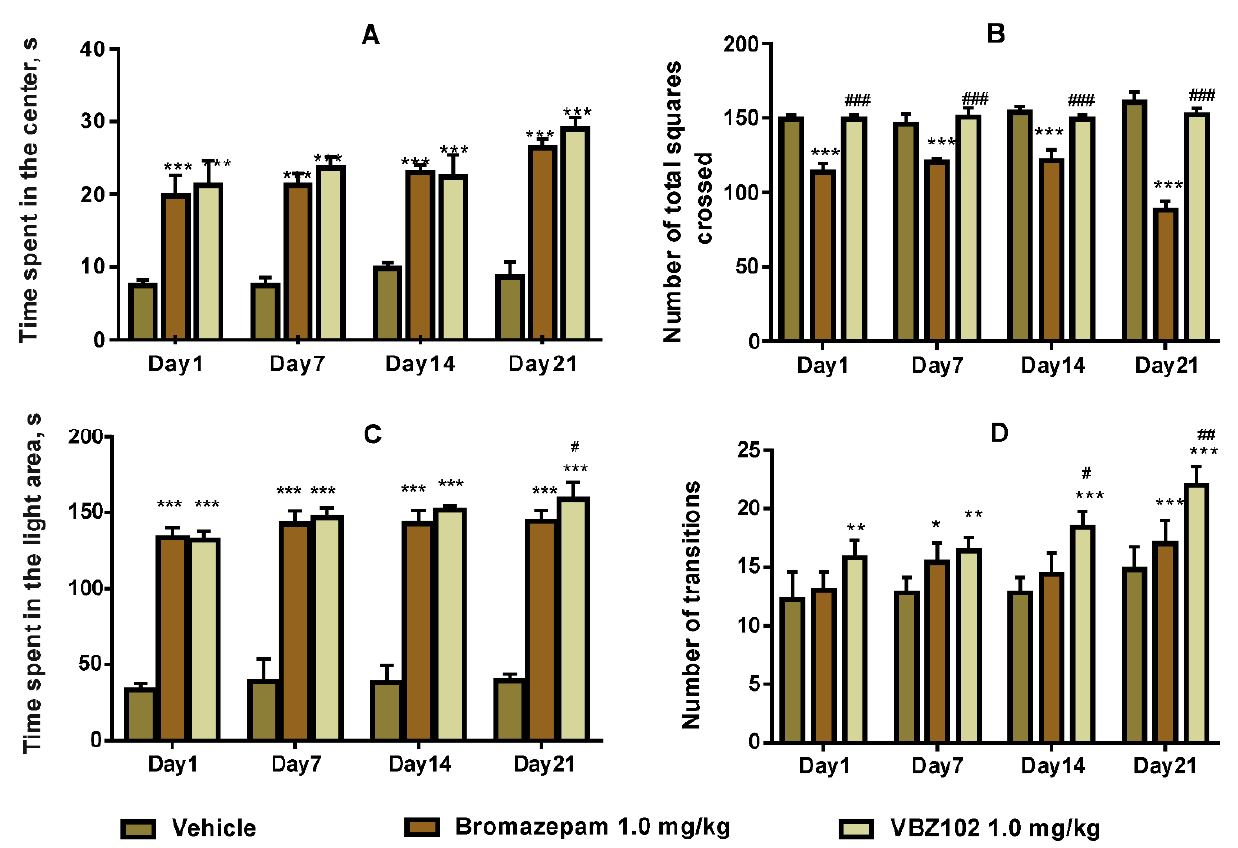
Figure 4. Effects of the VBZ102, vehicle, and bromazepam on ( A ) the time spent in the center in the open field test, ( B ) the number of total squares crossed in the open field test, ( C ) the time spent in the light area in the LDB test, and ( D ) the number of transitions between the light and dark compartments in the LDB test. The data are expressed as mean ± standard deviation. The analysis was done using two-way repeated-measures analysis of variance followed by the Tukey post-hoc test. *** p ≤ 0.001, ** p ≤ 0.01, * p ≤ 0.05, compared to the respective session of the vehicle group. ### p ≤ 0.001, ## p ≤ 0.01, # p ≤ 0.05, compared to the bromazepam group.